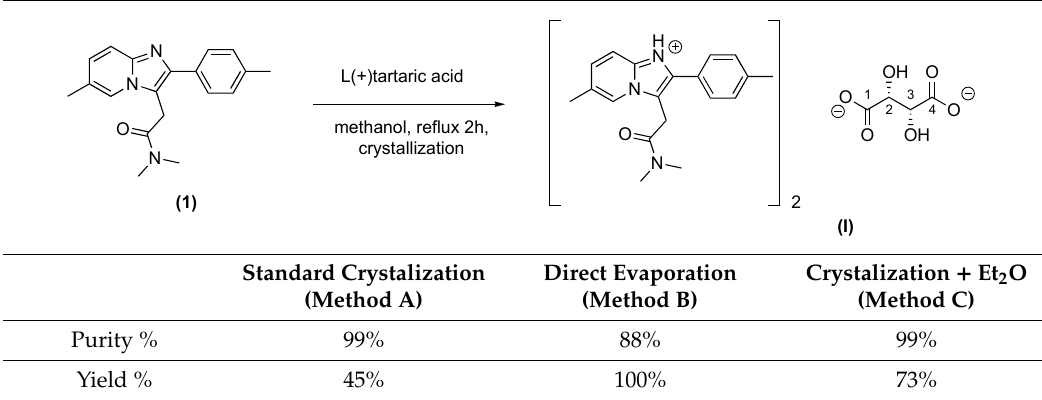
Table 5. Preparation of zolpidem tartrate (I) by diverse protocols.